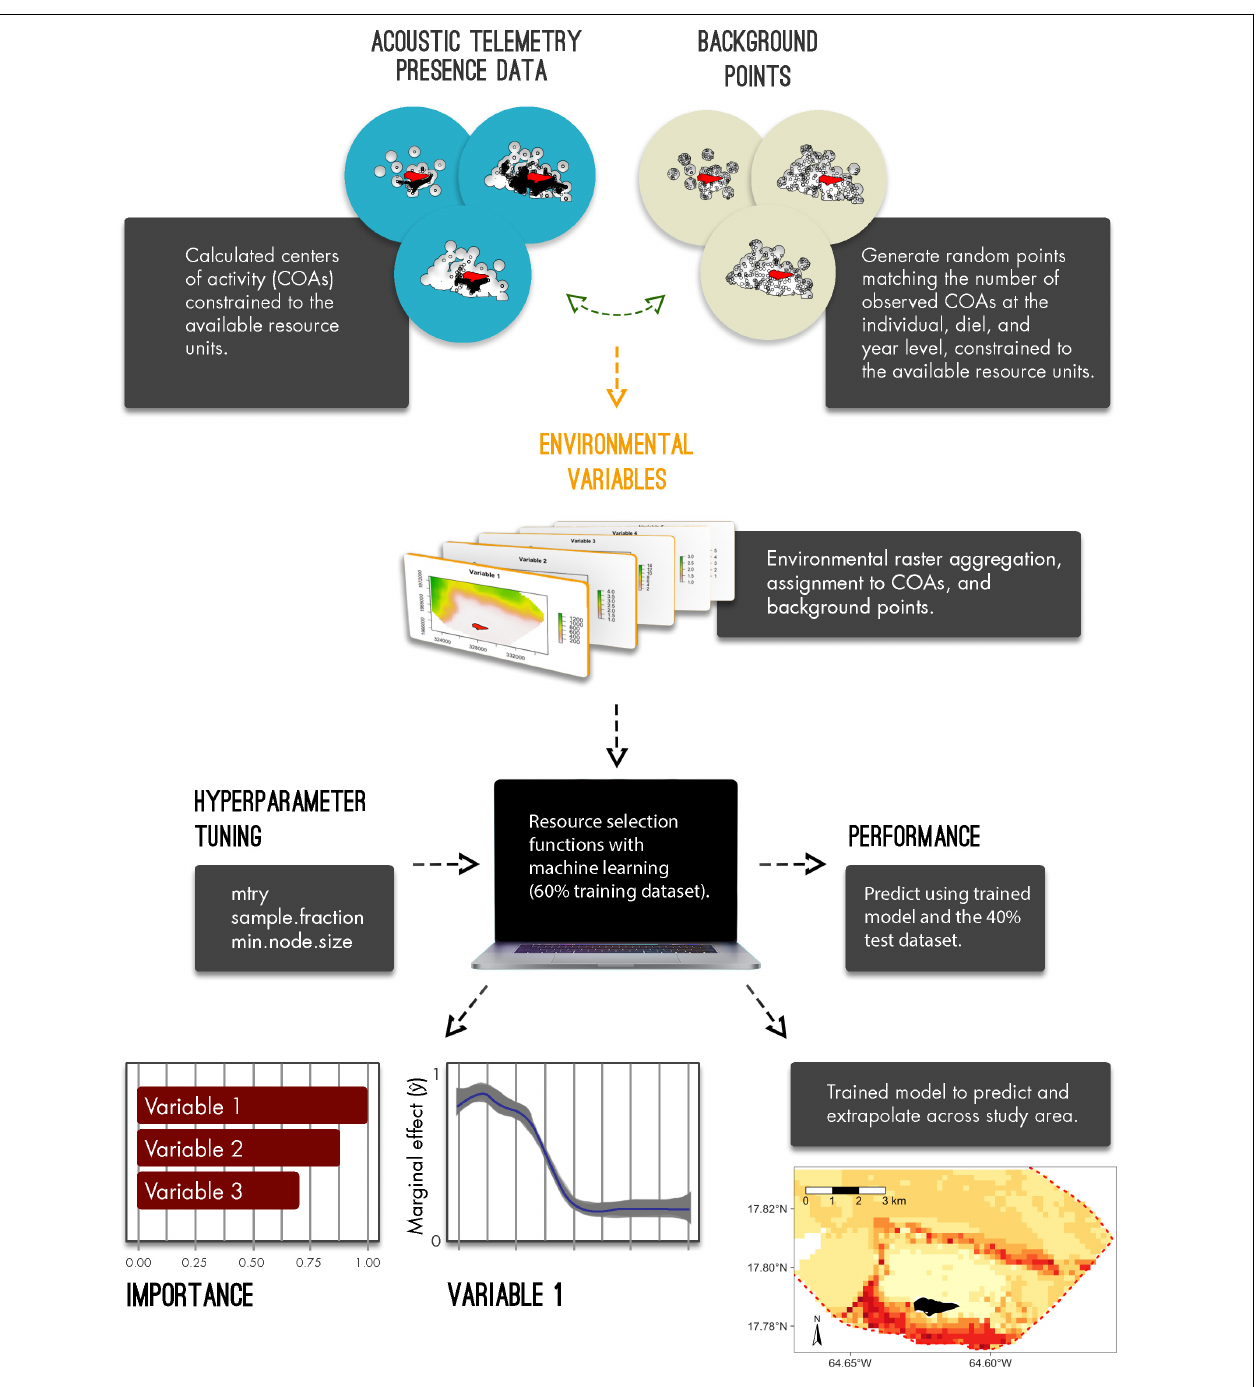
FIGURE 1 | Conceptual diagram to implement resource selection functions with acoustic telemetry and machine learning algorithms; from generated centers of activities and background points, deriving available resource units, model development, model performance and interpretation, and, ultimately, predicting and extrapolating relative